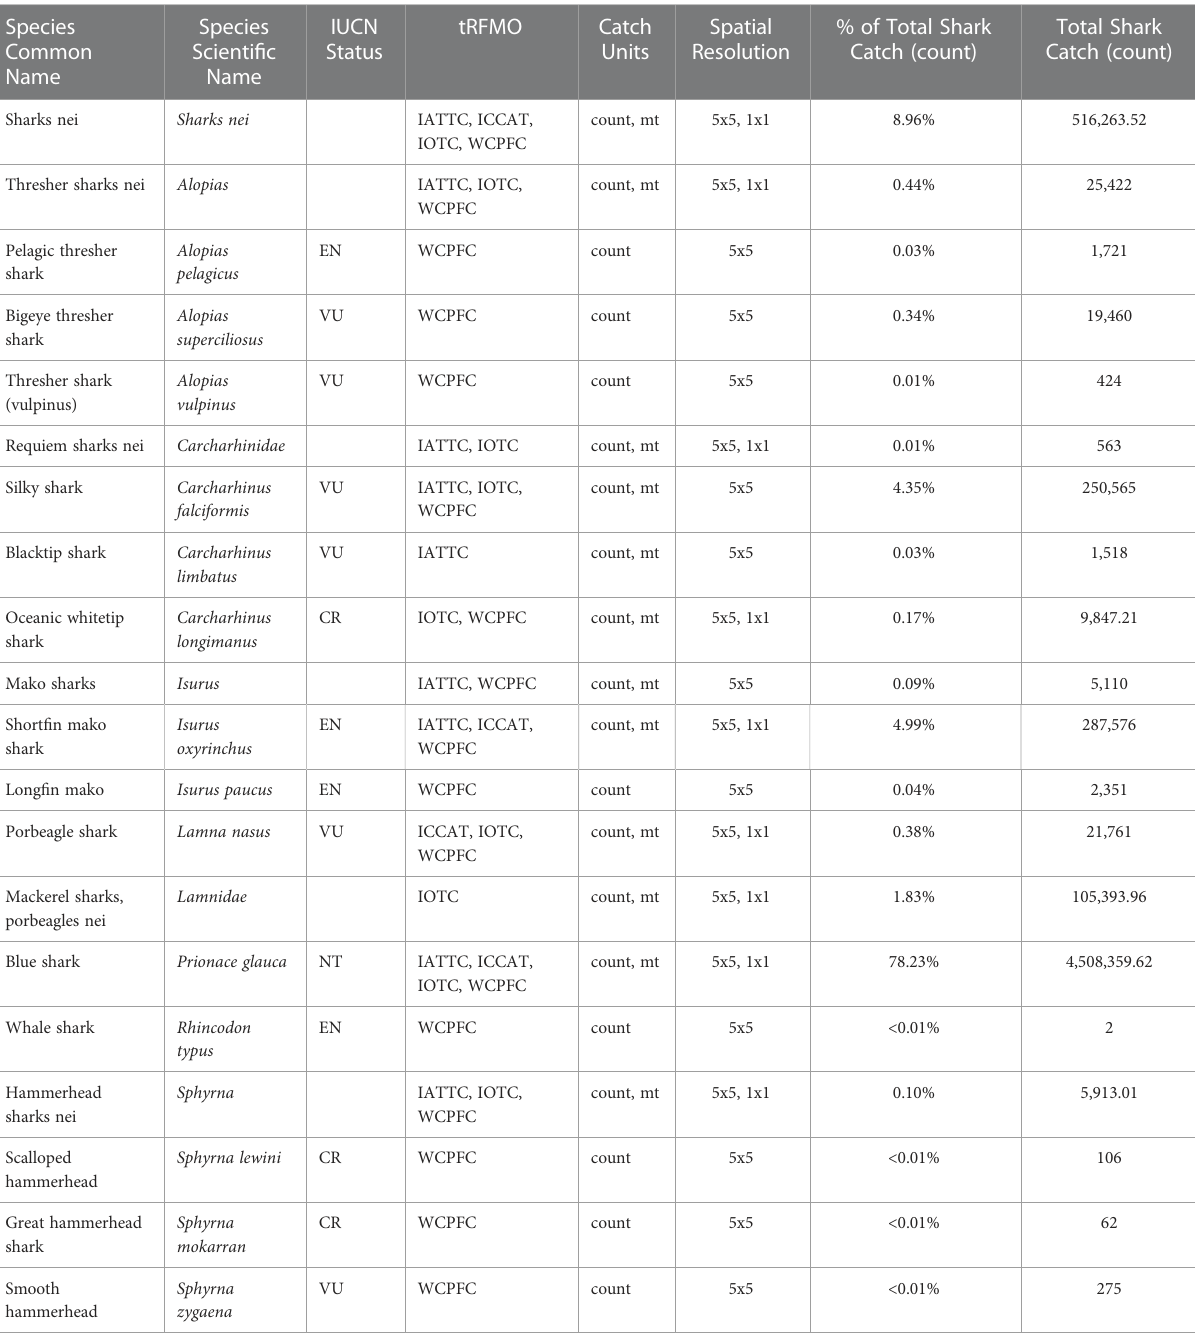
TABLE 1 Data overview by shark